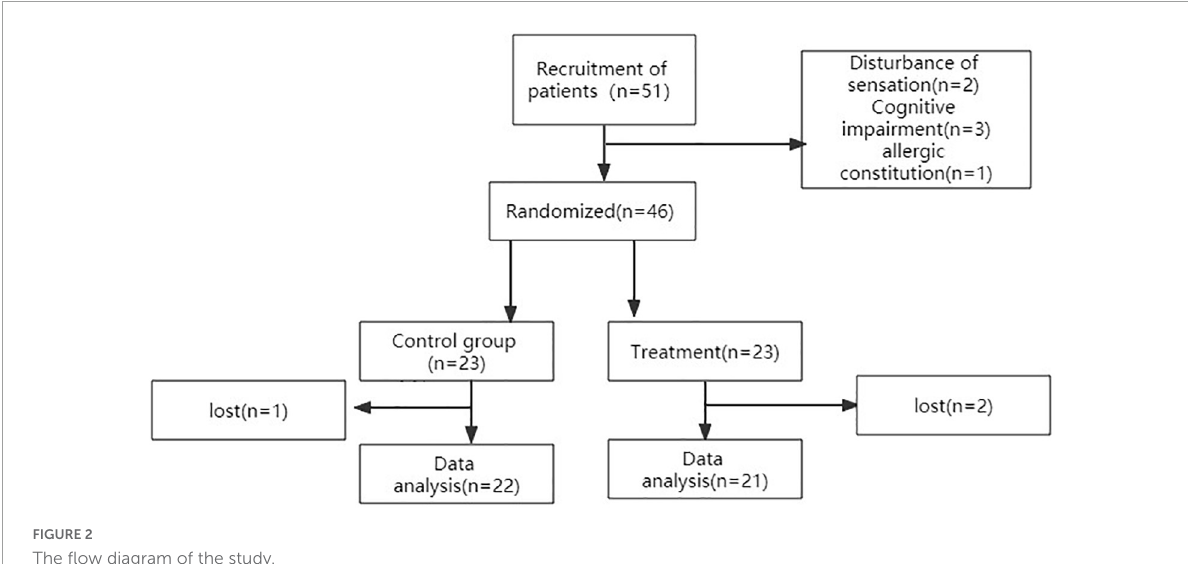
FIGURE2 The flow diagram of the study.